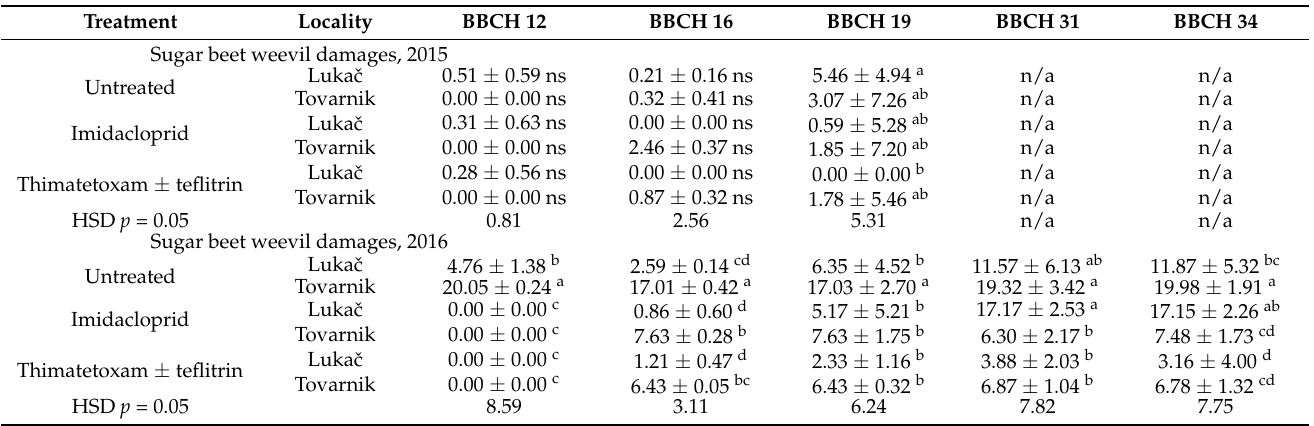
Table 5. Sugar beet weevil damage (according to Towsend-Heuberger) on sugar beet plants in different developmental stages